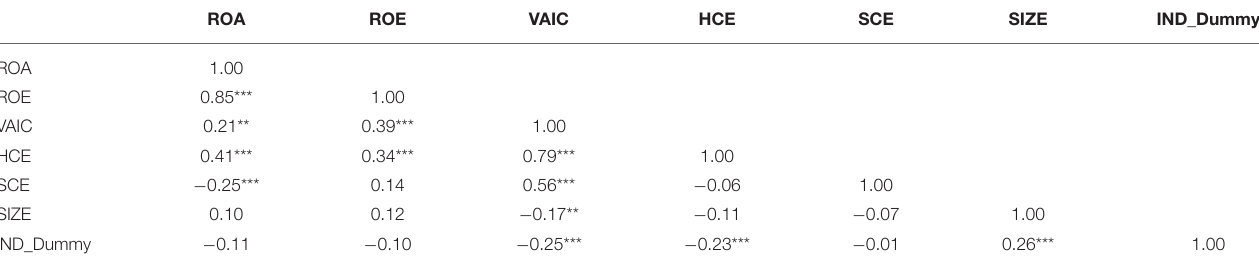
TABLE 2 | Correlation among variables. ROA ROE VAIC HCE SCE